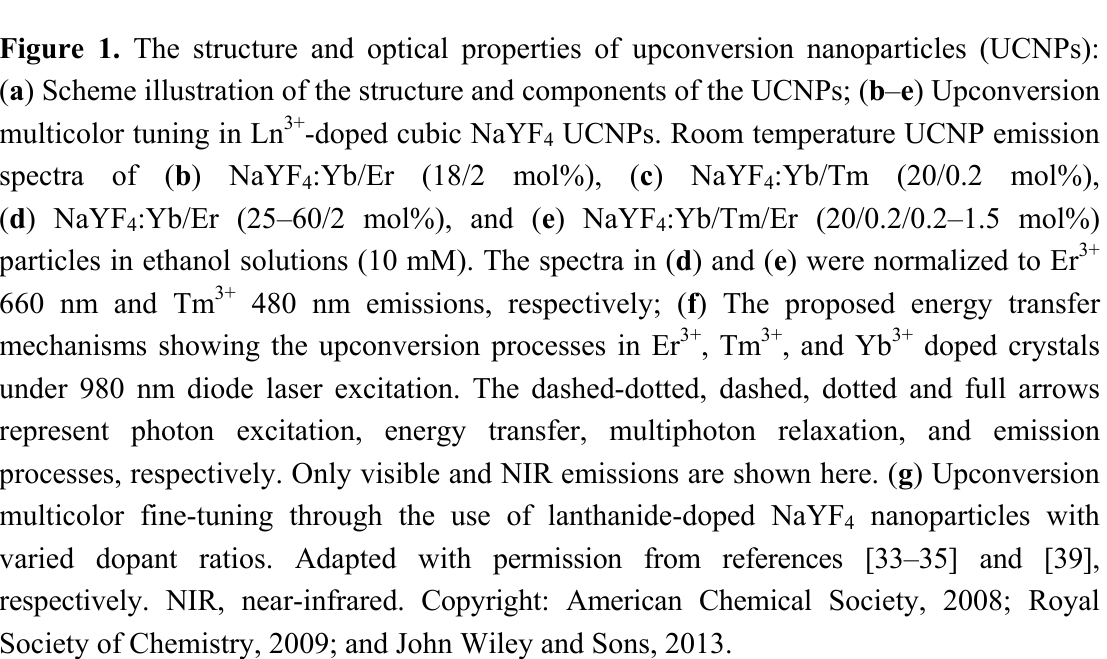
Figure 1. The structure and optical properties of upconversion nanoparticles (UCNPs): ( a ) Scheme illustration of the structure and components of the UCNPs; ( b – e )